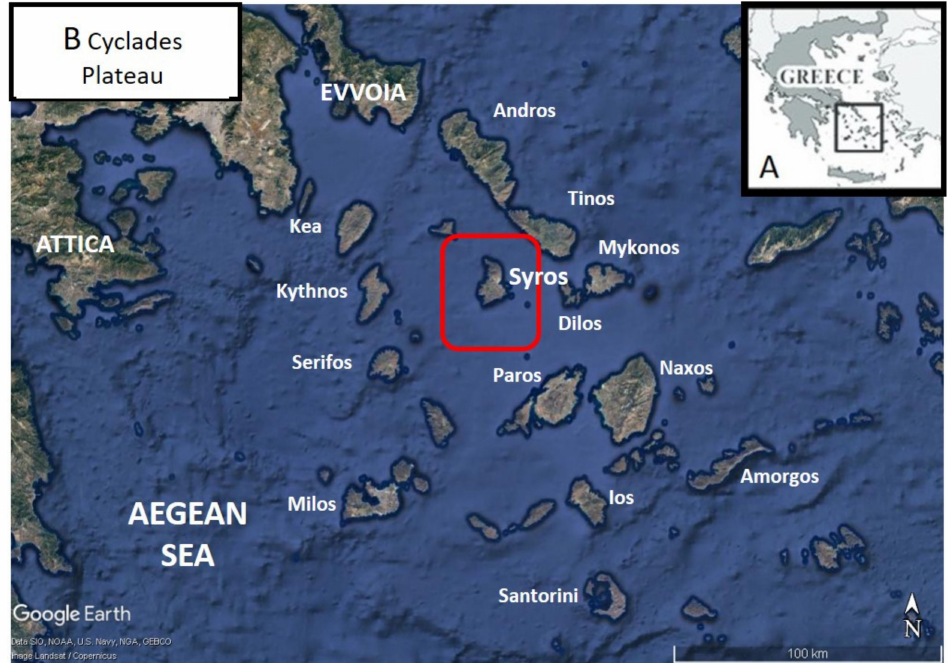
Figure 1. ( A ). Sketch map of Greece indicating the location of Cyclades Plateau, ( B ). Satellite photo of the Cyclades plateau, indicating the location of Syros